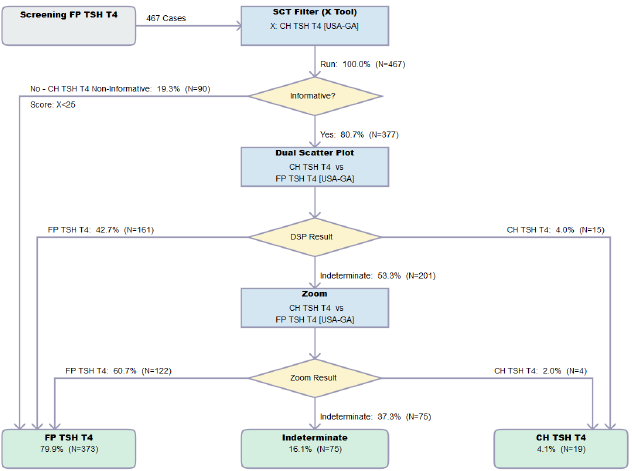
Figure 8. Result flow of the Dual Scatter Plot Runner. Legend: Resolution by the CLIR Dual Scatter Plot Runner of 467 FP cases with elevated TSH and low T4 from location Georgia (USA-GA). Single Condition Tool is CH TSH T4 version 026 created 1 February 2021, Dual Scatter Plot CH TSH T4 vs. FP TSH T4 version 027 created 1 February 2021. Image is shown unedited as created automatically by the software. Color coding as follows: Grey, start; Blue, process; Yellow: decision; Green, totals.